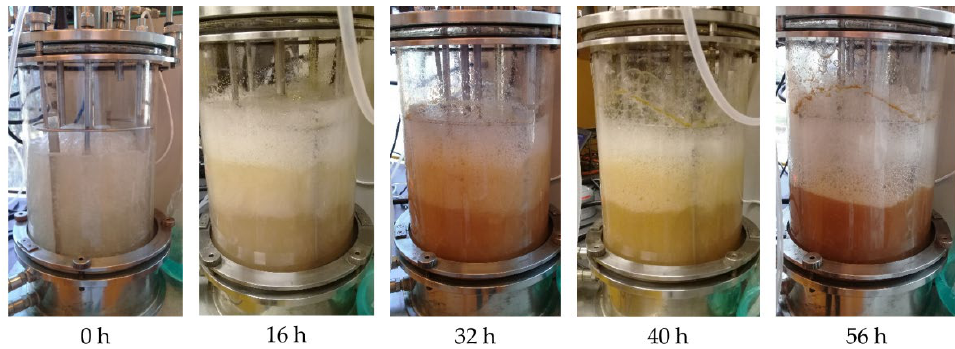
Figure A10. Pictures of culture #3 at different times of the fermentation process.